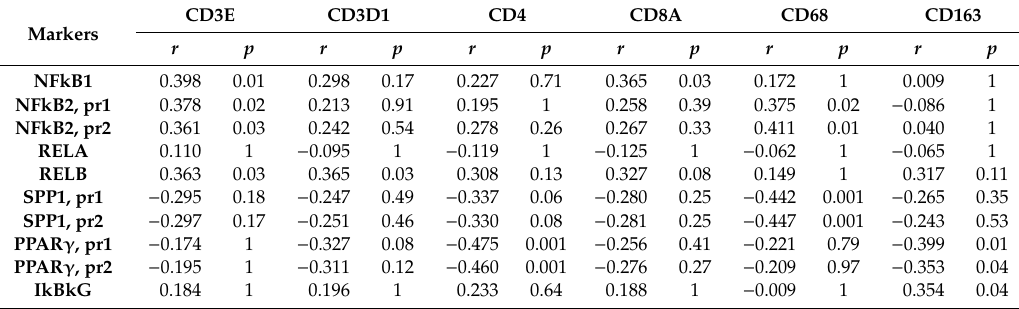
CD3E CD3D1 Markers